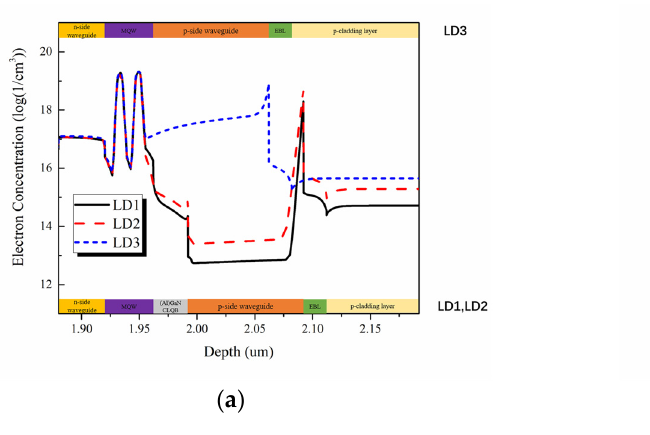
Figure 10. The simulated electron and hole concentration distribution around MQW of three LDs. ( a ) electron concentration distribution at an injecting current of 120 mA; ( b ) hole concentration distribution at an injecting current of 120 mA. Table 2. Comparisons of simulation results among three LDs. For convenience, the threshold current is taken when the optical output power reaches 1